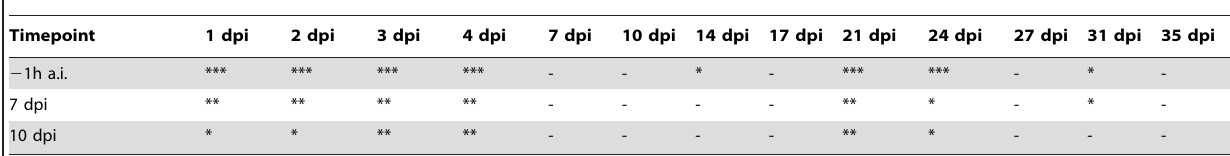
Data are given in Figure 1. Mann-Whitney rank sum test was used to compare the amount of copy numbers per mL blood at different time points. Significant differences are indicated by * P # 0.05, ** P # 0.01, *** P # 0.001. a.i. ante infectionem . dpi days post inoculation. h